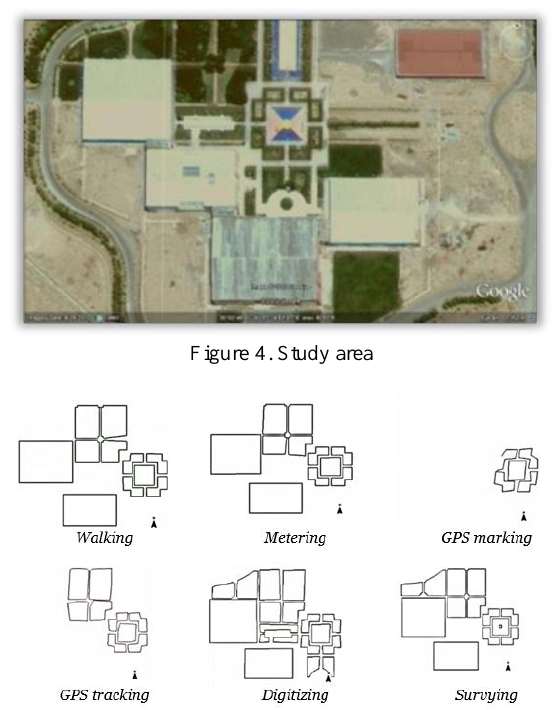
Figure 5. Examples of the produced maps from the study area